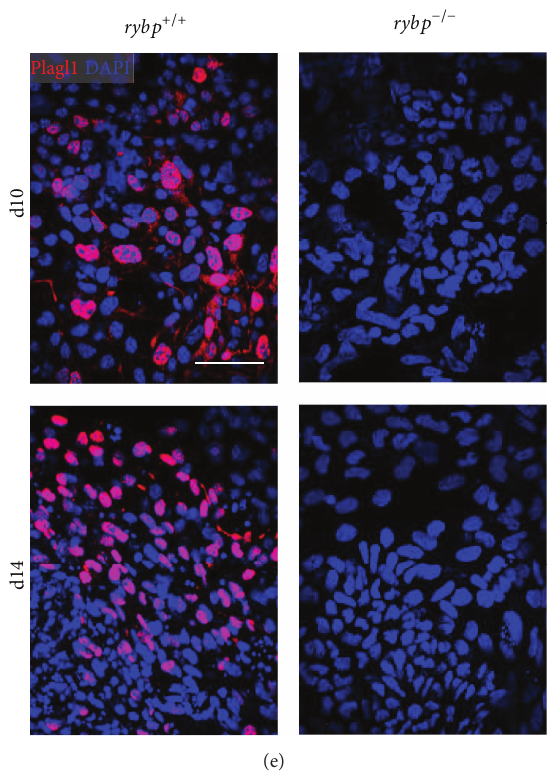
Figure 4: Rybp deficient cells show impaired protein expression of neural markers during in vitro neural differentiation. Immunocytochem- ical analysis of in vitro differentiated neural cultures shows that there are more Nestin (a) and Pax6 (b) and less Tuj1 (c) are visible in the rybp null mutant neural cell cultures by d10. Nestin and Tuj1 staining are reduced in the 𝑟𝑦𝑏𝑝 −/− cell culture by d14 compared to wild type, which indicates possible defects in the late neural processes. Immunostaining of astrocyte marker, Gfap (d), shows a small amount of astrocyte-like cells in wild type culture, which is absent in the mutant. Immunocytochemistry with antibody against Plagl1 (e) reveals that Plagl1 is expressed in the nucleus of 𝑟𝑦𝑏𝑝 +/+ cells but it is absent in 𝑟𝑦𝑏𝑝 −/− cells. Magnification is 60x. Scale bars represent 60 𝜇